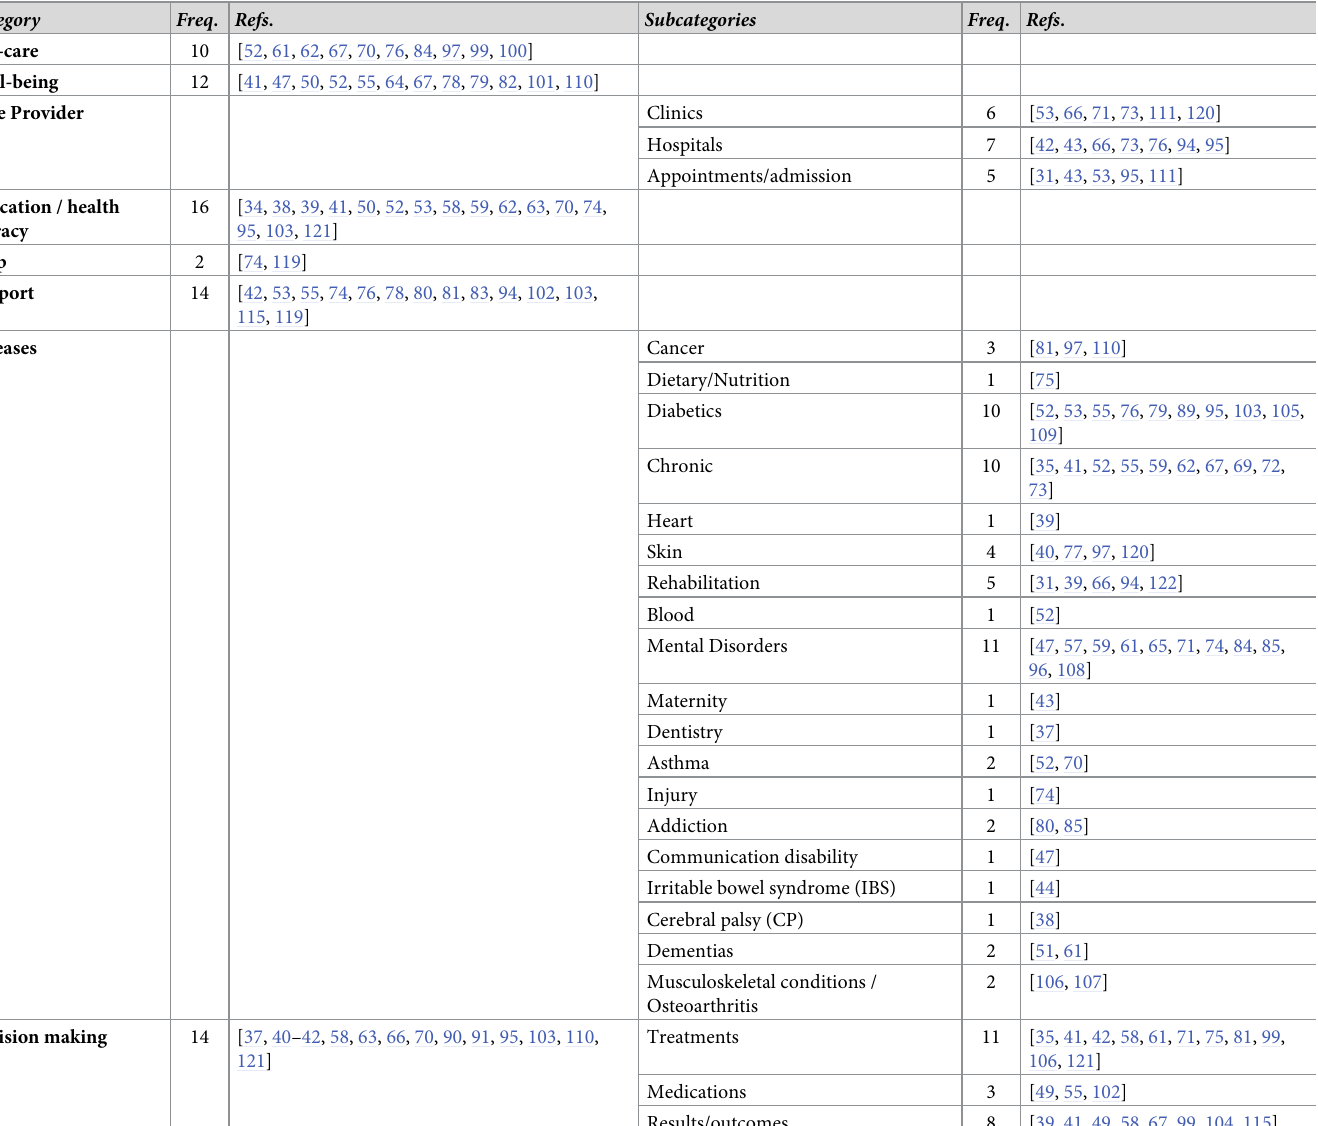
Table 6. Summary of findings in the reviewed literature: Health care. Category Freq . Refs